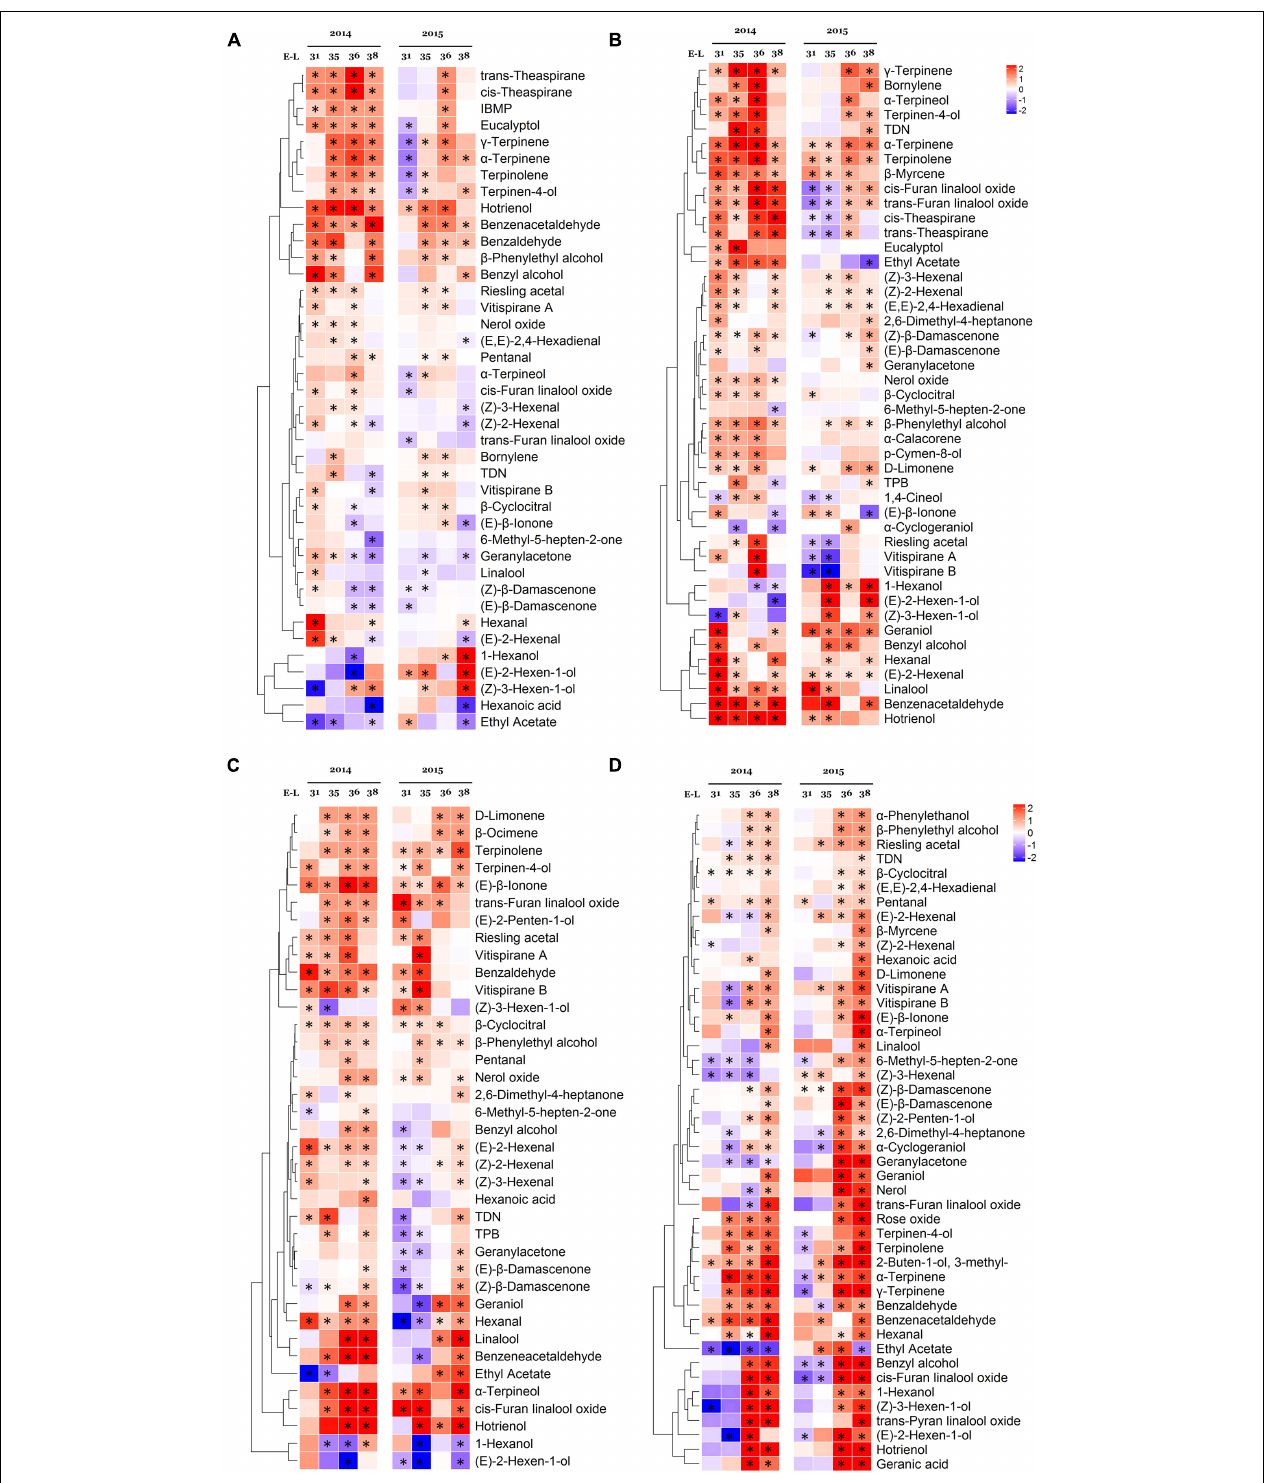
FIGURE 3 | Effect of the growing season on the free volatile compounds in Cabernet Sauvignon (A) , Riesling (B) , Victoria (C) , and Muscat Hamburg (D) grapes during fruit development in 2014 and 2015. Heatmaps show the log 2 fold changes between seasons (winter season/summer season). Red block indicates higher aroma concentrations in the winter season berries. Blue block indicates lower aroma concentrations in the winter season berries. ∗ Significant differences between the summer and winter season ( p < 0.05, t -test). IBMP, 2-isobutyl-3-methoxypyrazine; TDN, 1,1,6-trimethyl-1,2-dihydronaphthalene; TPB, ( E )-1-(2,3,6-trimethylphenyl)buta-1,3-diene.